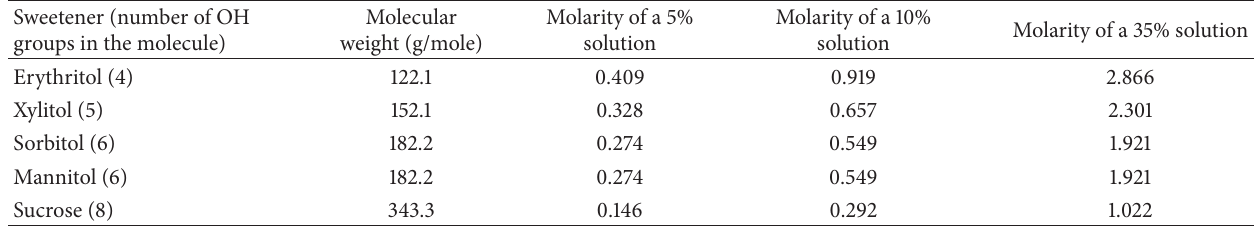
Table 1: Relationship between the molarities and grams per 100 mL values in aqueous solutions of some dietary sugar alcohols and sucrose. Sweetener (number of OH